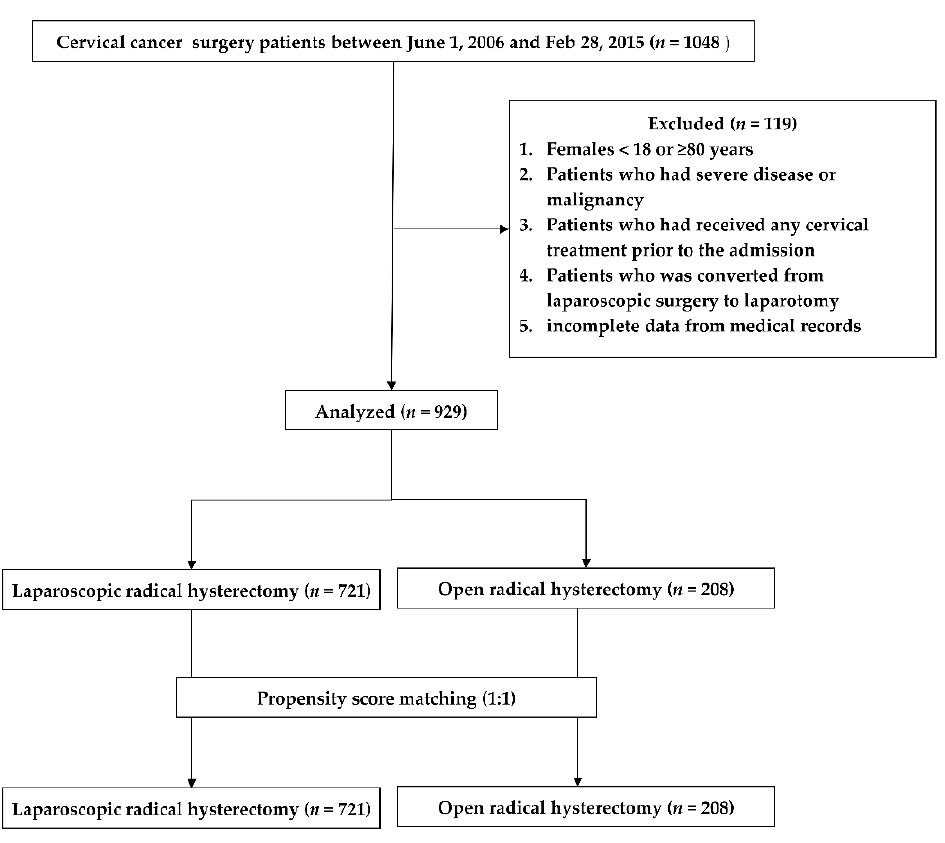
Figure 1. Study flow